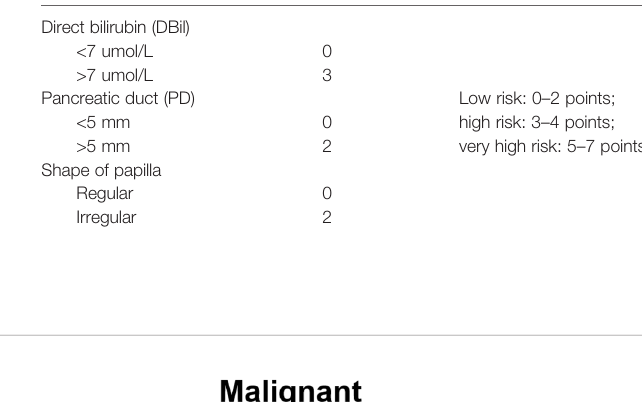
TABLE 5 | The scoring system for preoperative prediction in the bulging duodenal papilla with malignancy. Evaluation